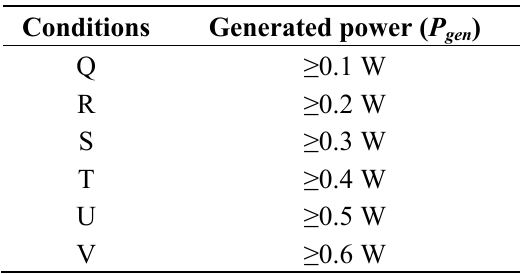
Table 1. Conditions of the generated